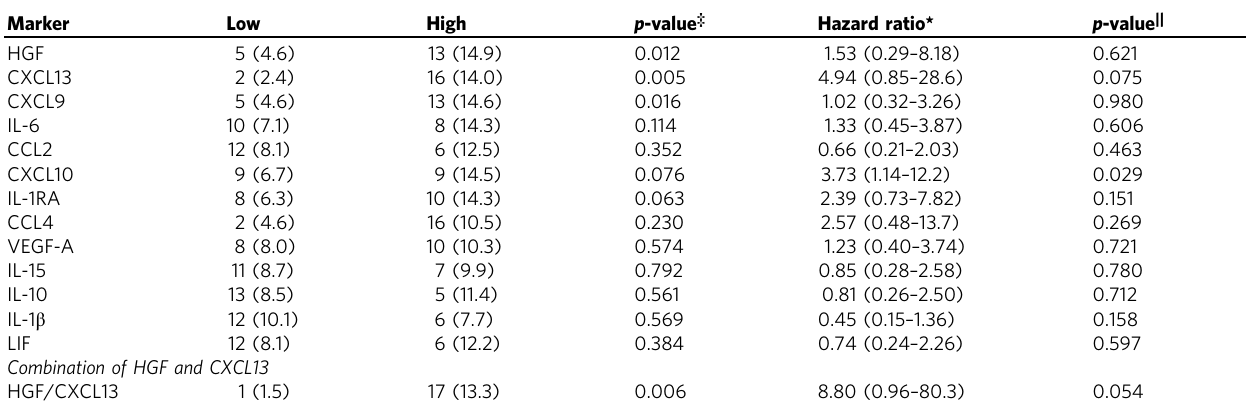
The fi rst two columns indicate the percentage of subjects within a given category (low or high levels) who died during follow-up, all cohorts together. *Adjusted for age (continuous), ICU stay (yes/no) and cohort (Lausanne 1/Lausanne 2/Paris), ‡ analysis by chi-square; ‖ , analysis by a multilevel survival model using a Weibull distribution, where patients were nested within each